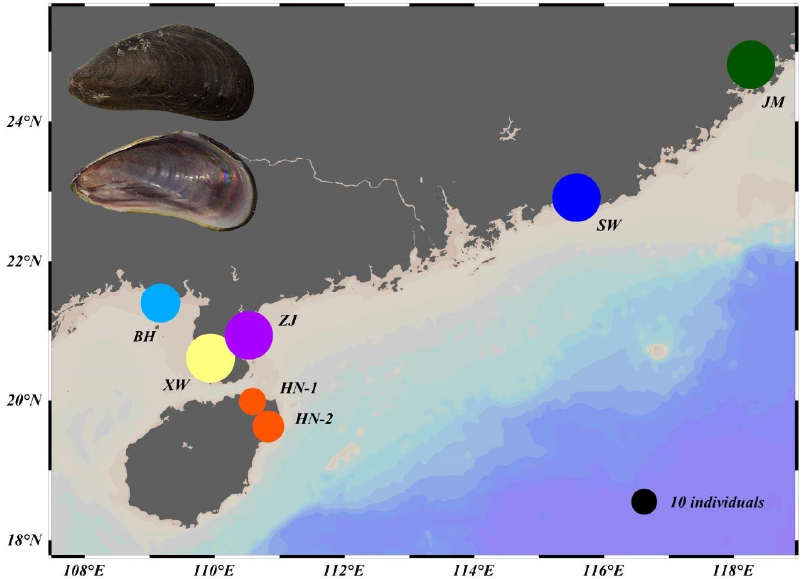
Figure 1. Chinese populations of Mytella strigata sampled in this study. The size of the circles indicates the number of samples from each population; the black circle (for reference) indicates 10 individuals. Table 1. Information on the samples collected and the number of sequences obtained in this study. The number of male-lineage gene sequences is shown in parentheses.